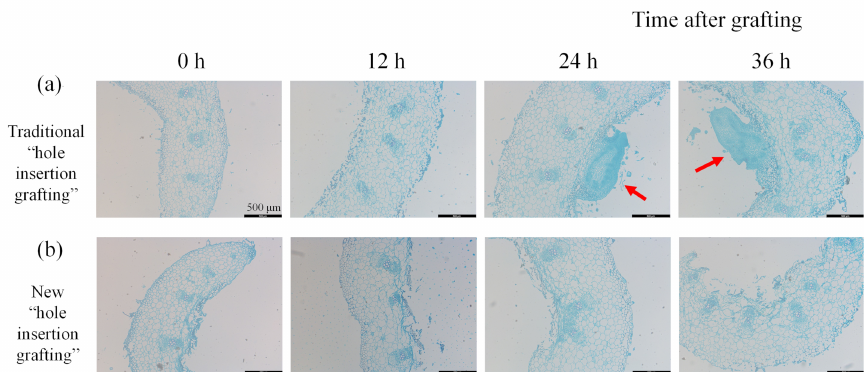
Figure 6. Anatomical observation of the pumpkin rootstock cotyledon base in the traditional ( a ) and the new “hole insertion grafting” ( b ) plants. Red arrow indicates rootstock